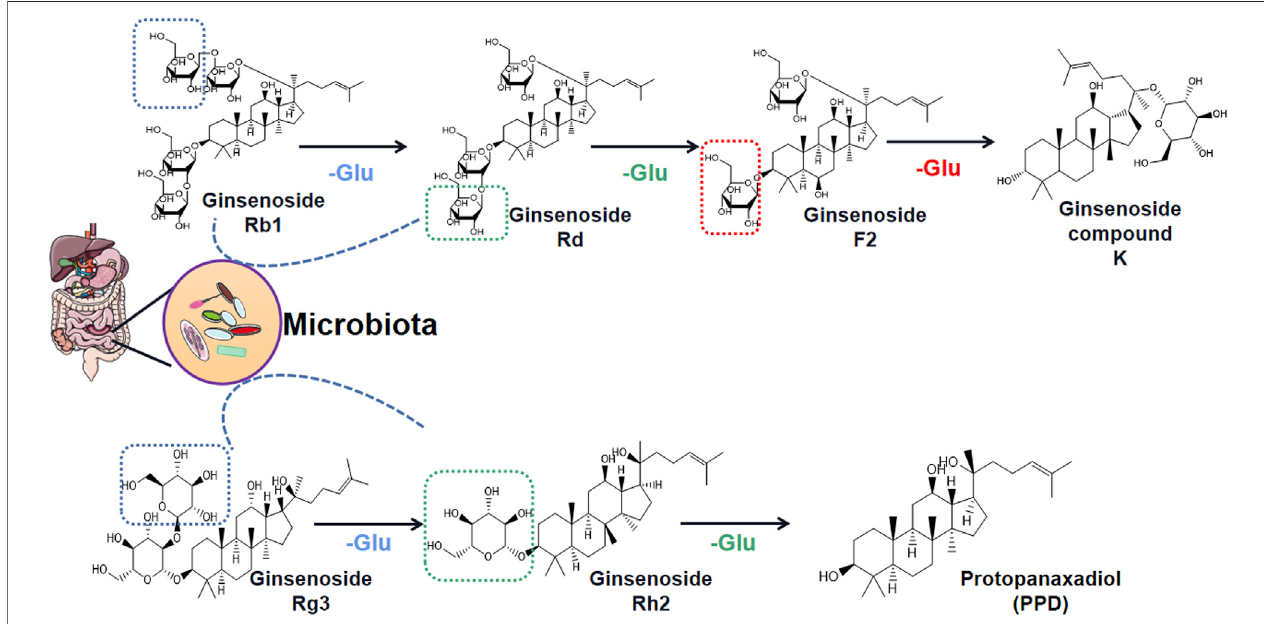
FIGURE 2 | Deglycosylation process of ginsenosides Rb1 and Rg3 through gut microbiota regulation.